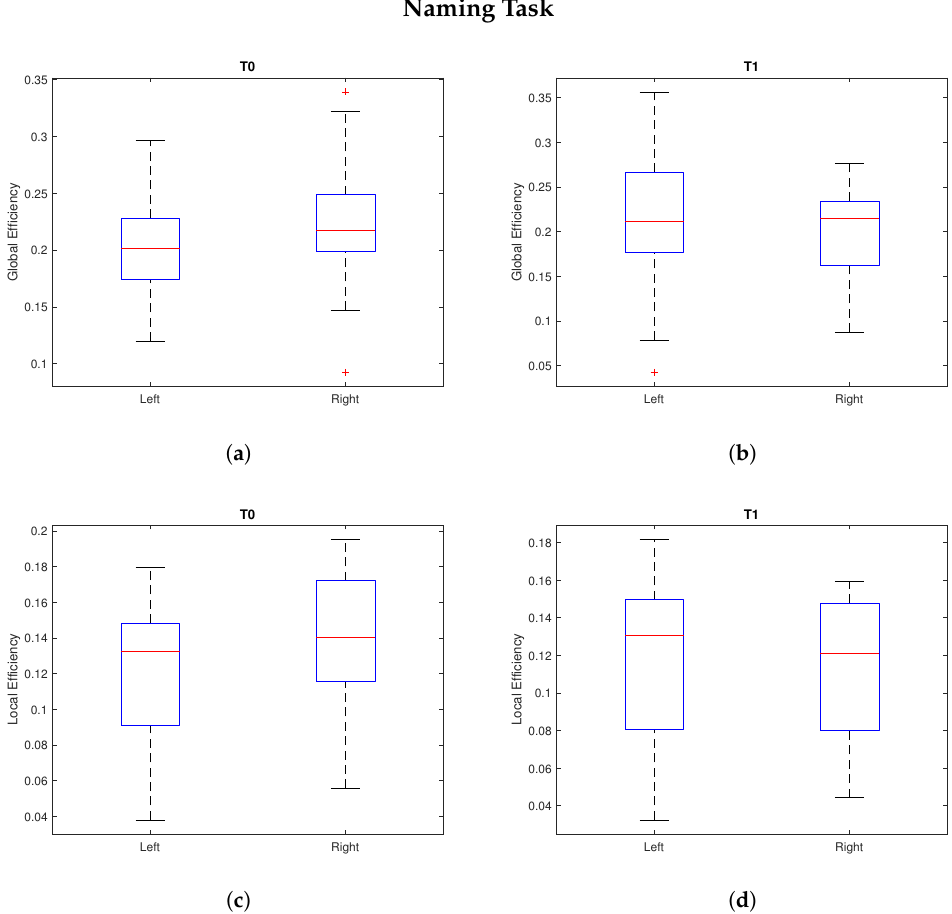
Figure 3. Naming task: boxplot of global efficiency for each hemisphere at time ( a ) T0 and ( b ) T1; boxplot of local efficiency for each hemisphere at time ( c ) T0 and ( d ) T1. On each box, the bottom and the top edges denote the 25th and 75th percentiles, respectively; the line inside the box indicates the median; the “whiskers” extend below and above the box up to the minimum and maximum data values, respectively. The ‘+’ marker symbol outside the whiskers represents the outliers.